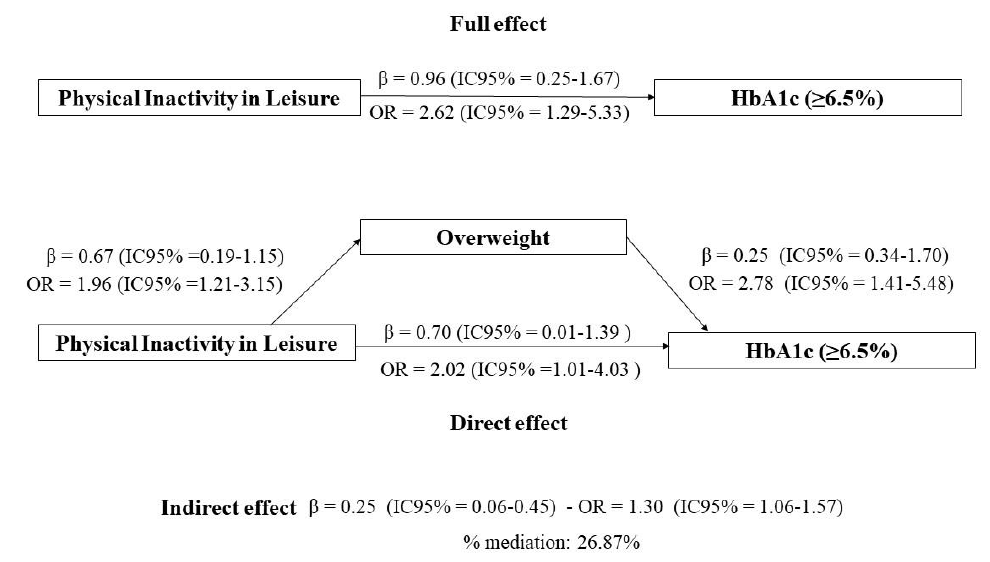
Figure 3. Mediation analysis of overweight between leisure time physical inactivity and high levels of HbA1c ( ≥ 6.5%) during the COVID-19 pandemic. Collection conducted in two Brazilian municipalities in the period October–December 2020. COVID-Inconfidentes, 2020. Legend: Explanatory variable; leisure time, physical inactivity. Outcome variable; glycated hemoglobin (HbA1c ≥ 6.5%). Mediating variable; overweight (BMI ≥ 25.0 kg/m 2 if <60 years or BMI ≥ 27.0 kg/m 2 if ≥ 60 years). Mediation model from Karlson–Holm–Breen method, adjusted according to directed acyclic graph according to minimum and sufficient set: age, sex, race/ethnicity, family income, and referred morbidity. Table 2. Association of leisure time physical inactivity with high levels of HbA1c.